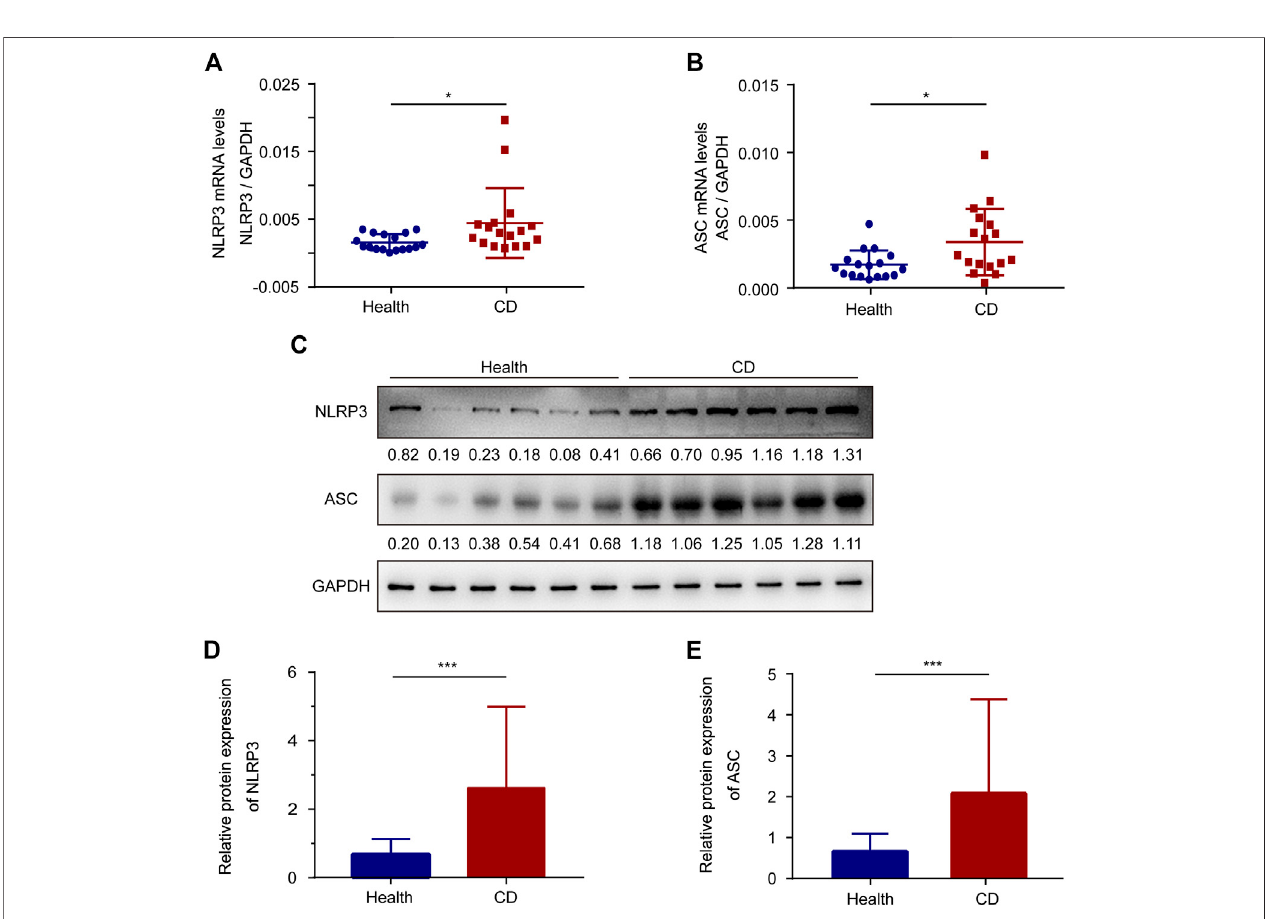
FIGURE 1 | The expression of ASC and NLRP3 in platelets from the healthy group and patients with active Crohn ’ s disease (CD). (A,B) The mRNA levels of NLRP3 (A) and ASC (B) were determined by RT-PCR in platelets from the healthy group ( n (cid:2) 17) and patients with active CD ( n (cid:2) 17). (C) Western blotting was used to determinetheproteinlevelsofNLRP3andASCinplateletsfrompatientswithactiveCDandthehealthygroup. (D,E) Therelativeproteinquanti fi cationofNLRP3 (D) and ASC (E) in platelets from the healthy group ( n (cid:2) 38) and patients with active CD ( n (cid:2) 38). Health, the healthy group; CD, the patients with active CD. Data are presented as mean ± SD, * p < 0.05, *** p <